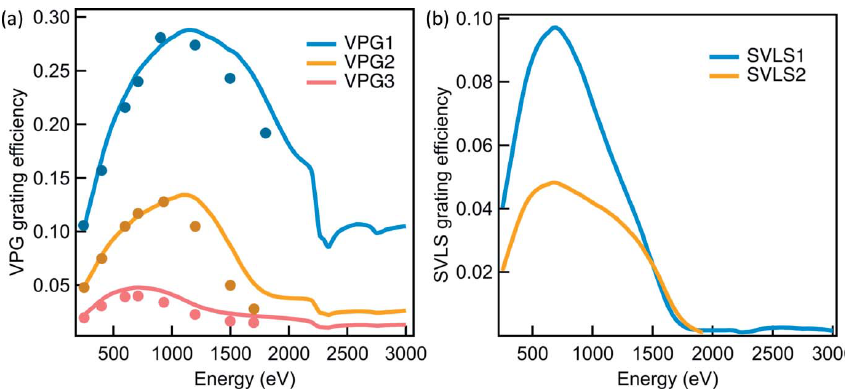
Figure 11 The simulated VPG and SVLS grating efficiencies (lines) as a function of energy. The results of the at-wavelength measurement (filled dots) on VPG gratings are also